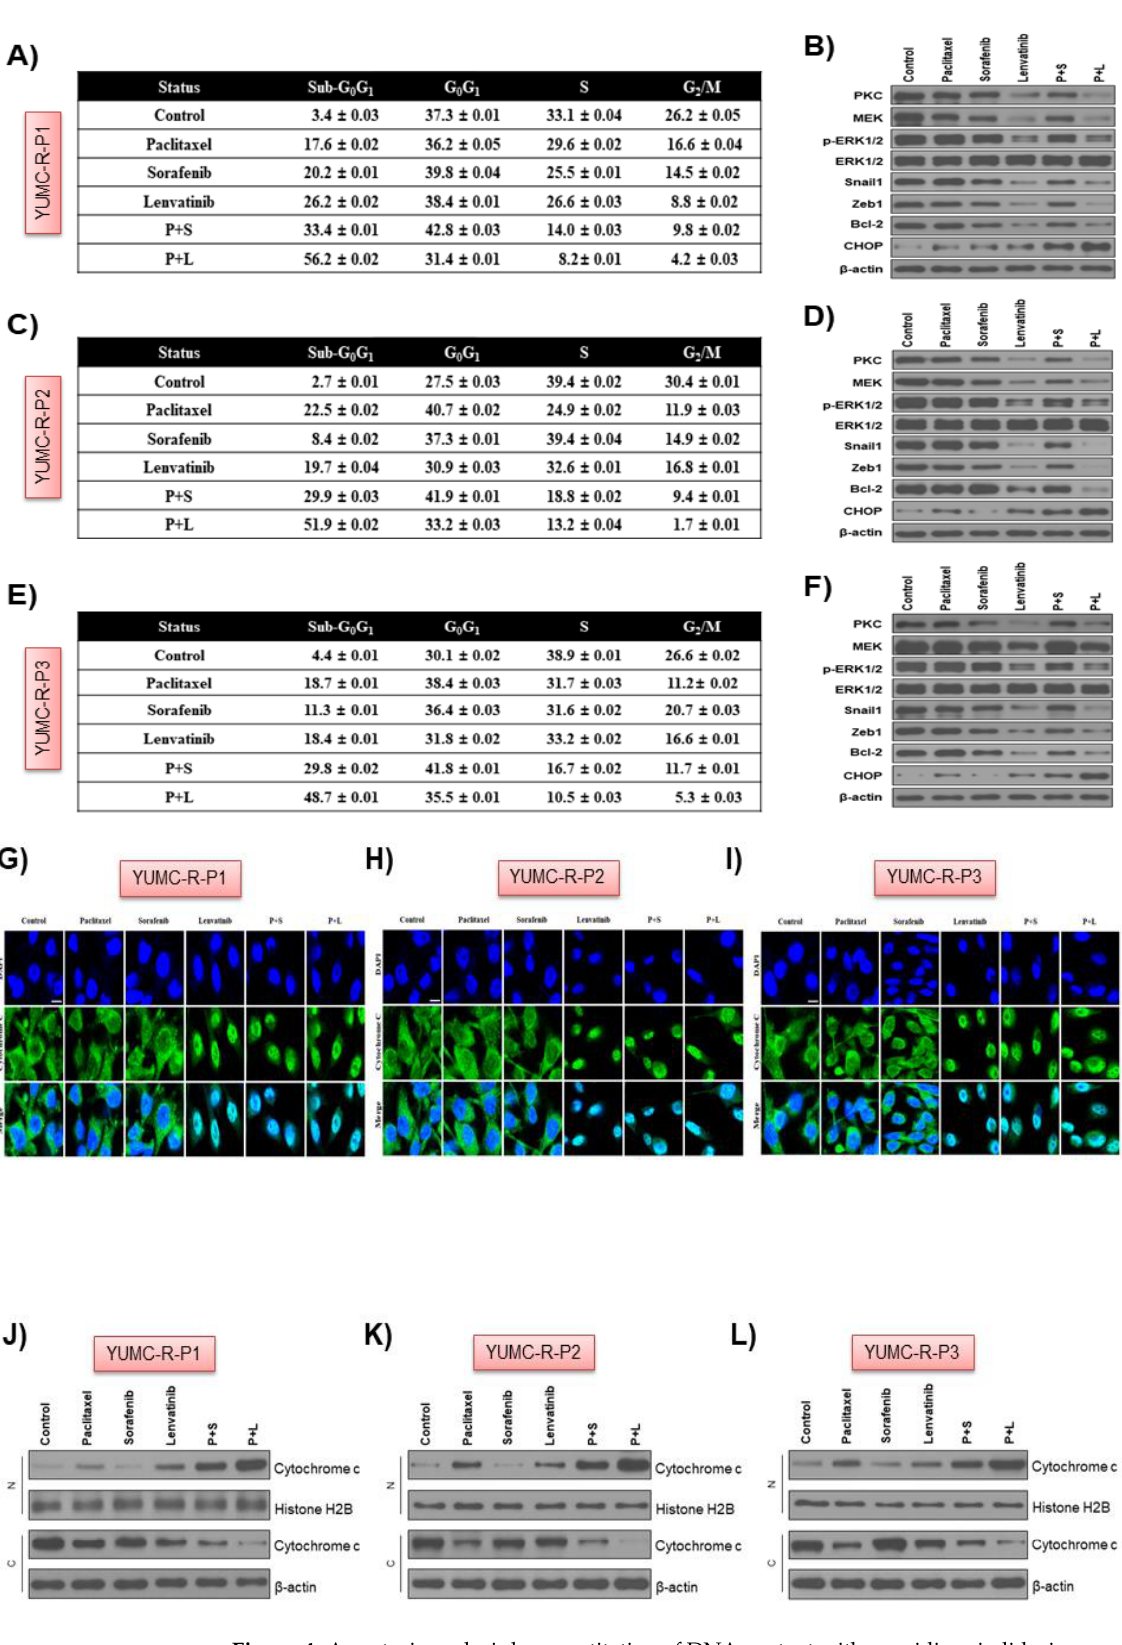
Figure 4. Apoptosis analysis by quantitation of DNA content with propidium iodide, immunoblot, and immunofluorescence analyses. Flow cytometry ( A , C , E ) and immunoblot analyses ( B , D , F ) of patient-derived anti-cancer drug-resistant papillary thyroid cancer (PTC) cells, YUMC-R-P1, YUMC-R-P2, and YUMC-R-P3. ( A , C , E ), Cells were exposed to the indicated inhibitors, harvested, and stained with propidium iodide before analysis by flow cytometry and further assessment us- ing FlowJo version 8. ( B , D , F ), Immunoblot analysis of the markers of endoplasmic reticulum stress, EMT, and anti-apoptosis in YUMC-R-P1, YUMC-R-P2, and YUMC-R-P3. ( G , H , I ), Immunofluo- rescence examined at 400 × magnification; scale bar: 20 μm and ( J , K , L ) subcellular fractionation analysis. ( J , K , L ), Cytochrome c was the most translocated, and it accumulated in the nucleus in the paclitxel and lenvatinib cotreatment group. Combination of paclitaxel and lenvatinib resulted in the most induced nuclear translocation of cytochrome c -mediated apoptosis in anti-cancer drug-resistant PTC cell lines, YUMC-R-P1, YUMC-R-P2, and YUMC-R-P3. 2.5. Paclitaxel and Lenvatinib Cotreatment Remarkably Suppressed Tumor Growth in a Mouse Xenograft Model with Patient-Derived Drug-Resistant PTC Cell Lines To determine the synergistic in vivo anti-cancer efficacy of the cotreatment with paclitaxel and lenvatinib, we established a mouse xenograft model with YUMC-R-P1, YUMC-R-P2, and YUMC-R-P3 patient-derived PTC cell lines (Figure 5). We found that paclitaxel, sorafenib, and lenvatinib alone could not significantly inhibit tumor growth; however, compared with using these agents alone, cotreatment with paclitaxel and len- vatinib induced drastic tumor shrinkage (Figure 5A,D,G). Of note, cotreatment with paclitaxel and sorafenib seemed to induce tumor shrinkage compared with that seen using paclitaxel, sorafenib, or lenvatinib treatment alone. However, tumor growth is steadily in- creasing (Figure 5A,D,G). Mice in the paclitaxel and lenvatinib cotreatment group had a markedly smaller dissected tumor weight than mice treated with paclitaxel, sorafenib, or lenvatinib alone or in combination with paclitaxel and sorafenib (Figure 5B,E,H). There was no evidence of systemic toxicity and mortality in any group. The body weight of mice did not remarkably differ between the groups (Figure 5C,F,I). Anti-apoptotic activity is critical for the estimation of tumorigenesis, and Bcl-2 serves as a marker of anti-apoptotic activity; therefore, we confirmed its presence by performing immunohistochemistry analysis on